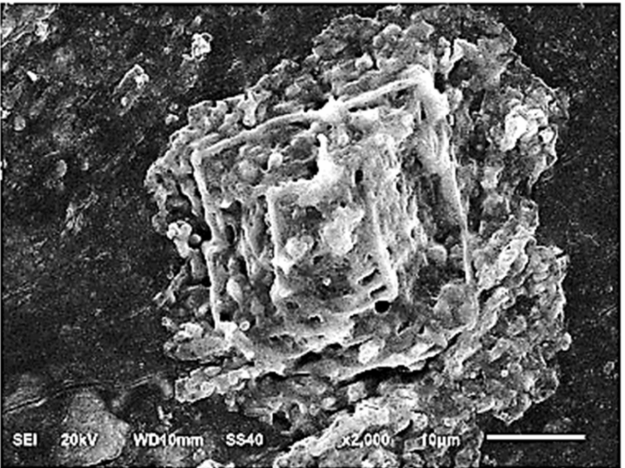
Figure 1. Manifests the scanning electron microscopy (SEM) image of the integrated Pectin/Polyvinyl alcohol coating that exhibited a cross-linked structure due to the formation of a Pectin/Polyvinyl alcohol